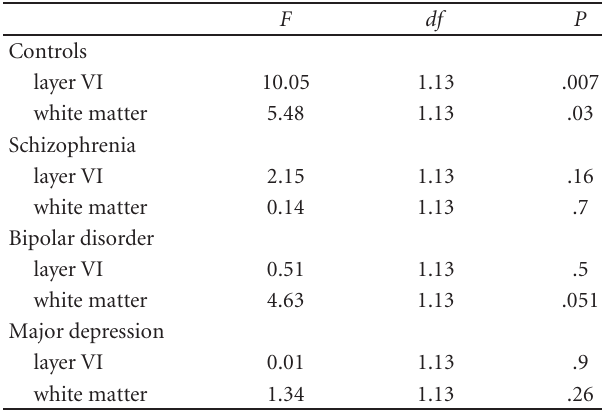
Table 3: Regression of Nv of oligodendrocytes on age in BA9.